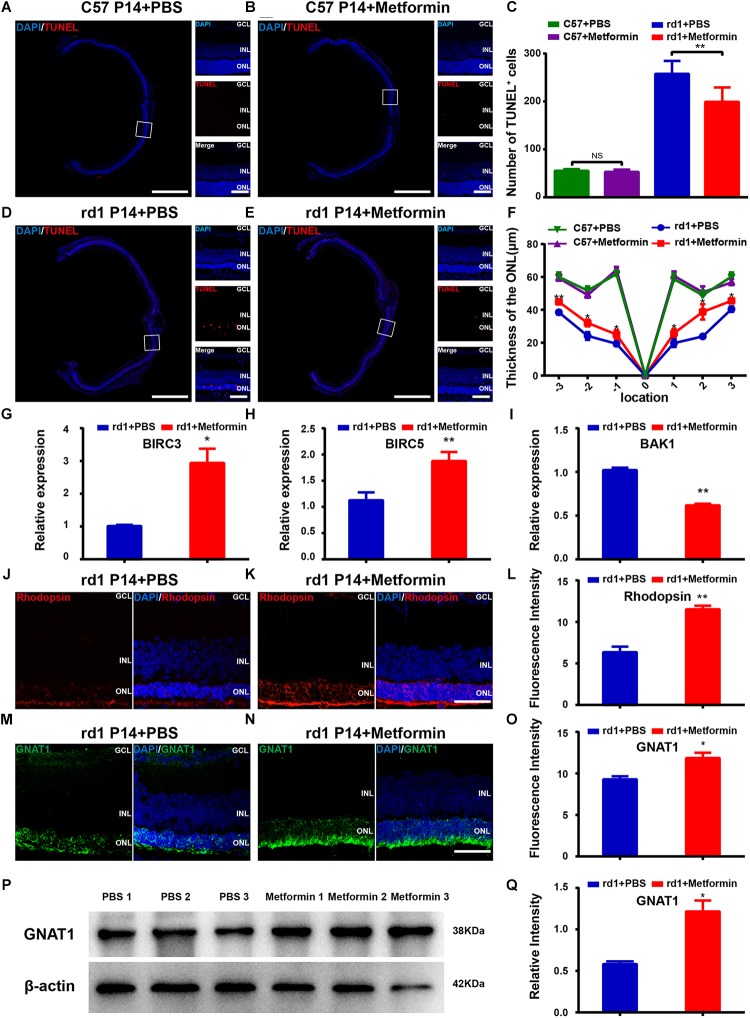
Metformin rescues photoreceptors from apoptosis in rd1 mice at P14. (A,B,D,E) Whole retinal montage and partial enlargement of TUNEL staining in the following differently treated groups of mice: (A) C57 mice treated with PBS; (B) C57 mice treated with metformin; (D) rd1 mice treated with PBS; (E) rd1 mice treated with metformin. A magnified view from a C57 mouse was obtained approximately 450 μm from the optic papilla, whereas the view obtained from the rd1 mouse was located approximately 400 μm from the optic papilla. (C) Comparison of the numbers of TUNEL-positive cells in the whole retina in C57 and rd1 mice in two treatment groups. n = 7 mice per group. (F) Comparison of ONL thickness at different positions of the retina in C57 and rd1 mice. n = 5 mice per group. (G–I) Real-time PCR analysis of the expression of BIRC3, BIRC5, and BAK1. n = 3 mice per group. Representative images of immunofluorescence for specific markers of photoreceptor cells (green/red) and DAPI (blue) in the mouse retina showing that the retina expresses Rhodopsin (J,K in red), GNAT1 (M,N in green): (G) Rd1 mice treated with PBS at P14; (H) rd1 mice treated with metformin at P14; (J) rd1 mice treated with PBS at P14; (K) rd1 mice treated with metformin at P14. (L,O) Quantitative analysis of the intensities of Rhodopsin (I) and GNAT1 (L) expression in the two groups shown in (G,H,J,K). n = 5 mice per group. (P) Representative Western blot bands of GNAT1 versus β-actin. (Q) Comparison of protein grayscale semiquantitative analysis between the control group and the Met group. GCL, retinal ganglion cell layer; INL, inner nuclear layer; ONL, outer nuclear layer. Data are presented as the mean ± SEM. NS, no significant difference, ∗P < 0.05, ∗∗P < 0.01. Scale bars: whole retinal map, 500 μm; enlarged view, 50 μm; (G,H,J,K) 50 μm.